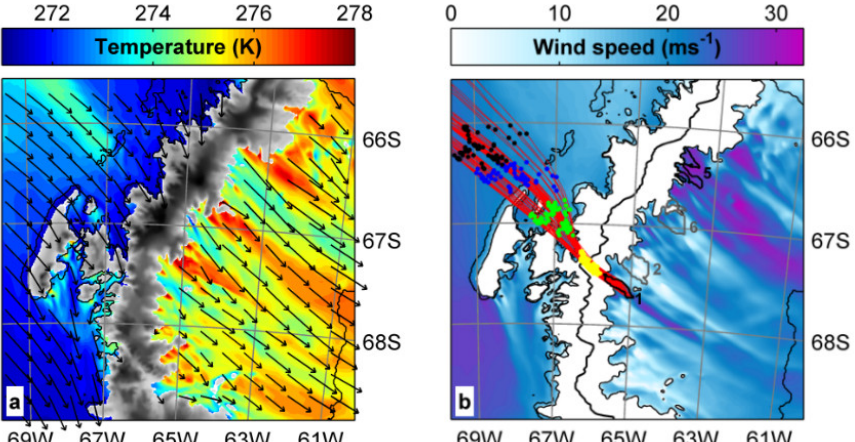
Figure 1. Numerical simulations of a foehn wind event affecting the Antarctic Peninsula. ( a ) Low-level temperature and wind vectors; ( b ) Low-level wind speed and back trajectories (red lines) initiated in a foehn jet over the Larsen Ice Shelf within Whirlwind Inlet (WI). Annotated on the back trajectories are coloured dots at 0, 50, 100, and 150 km upwind of the Peninsula’s crest. The regions marked 1 and 2 are, respectively, the Whirlwind Inlet jet and N of Whirlwind Inlet wake trajectory initiation regions.